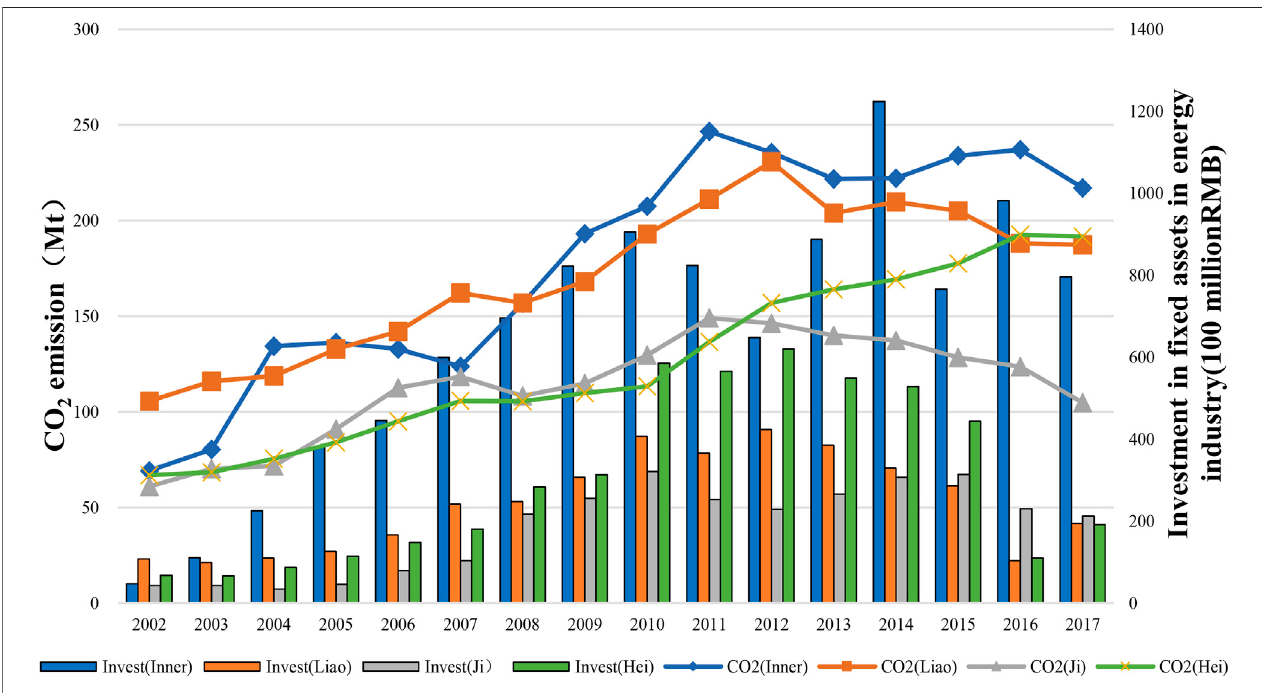
FIGURE 2 | Evolution of investment in fi xed assets in the energy industry and CO 2 emissions in the four northeastern regions.